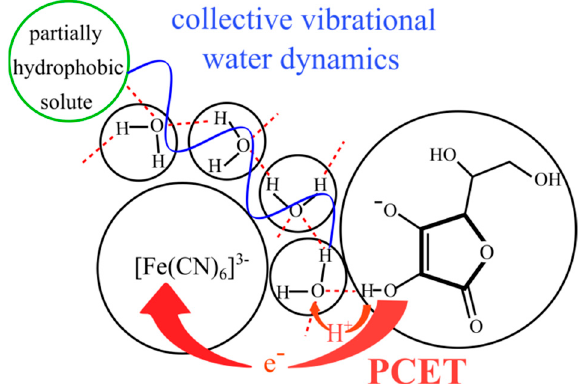
Figure 6. Schematic representation of transition configuration in the PCET ascorbate interaction with hexacyanoferrate(III) ion.